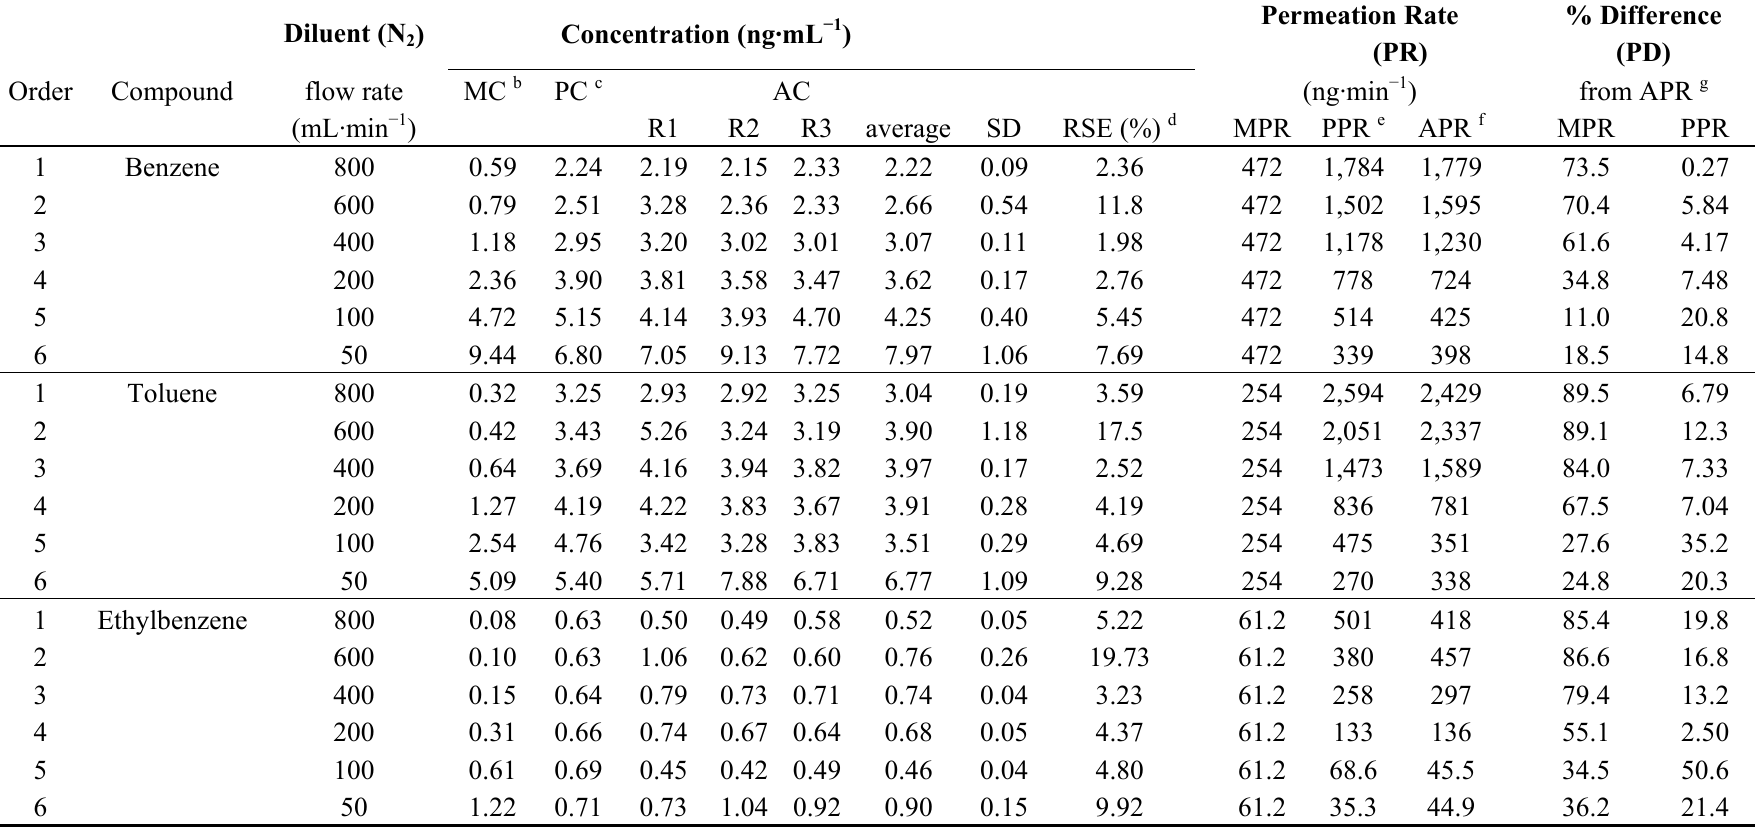
Table 4. Experimental bias in estimating permeation rates of BTEX based on three different definitions for permeation rates a